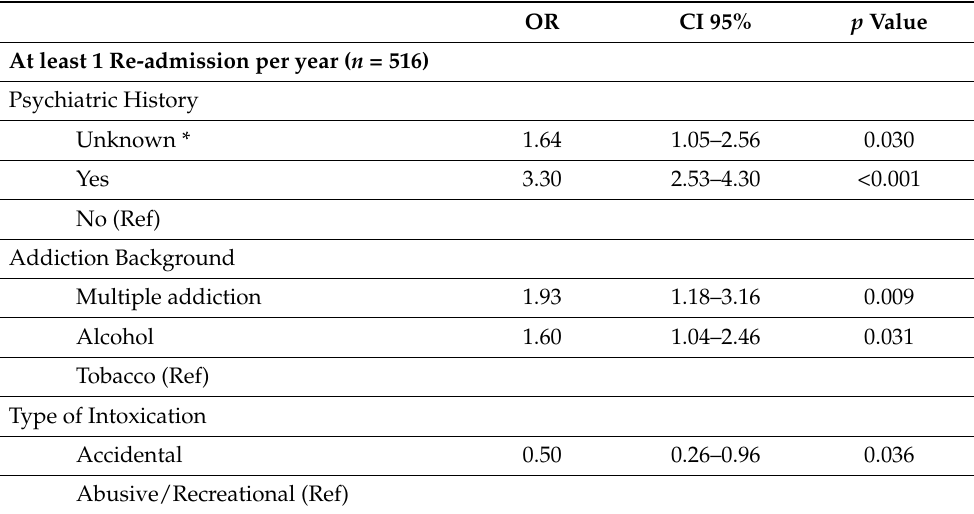
Figure 2. Time elapsed from admission to the ED for APC to readmission. Survival analysis using Kaplan–Meier curves. Table 2. Multivariate analysis. Results of multiple logistic